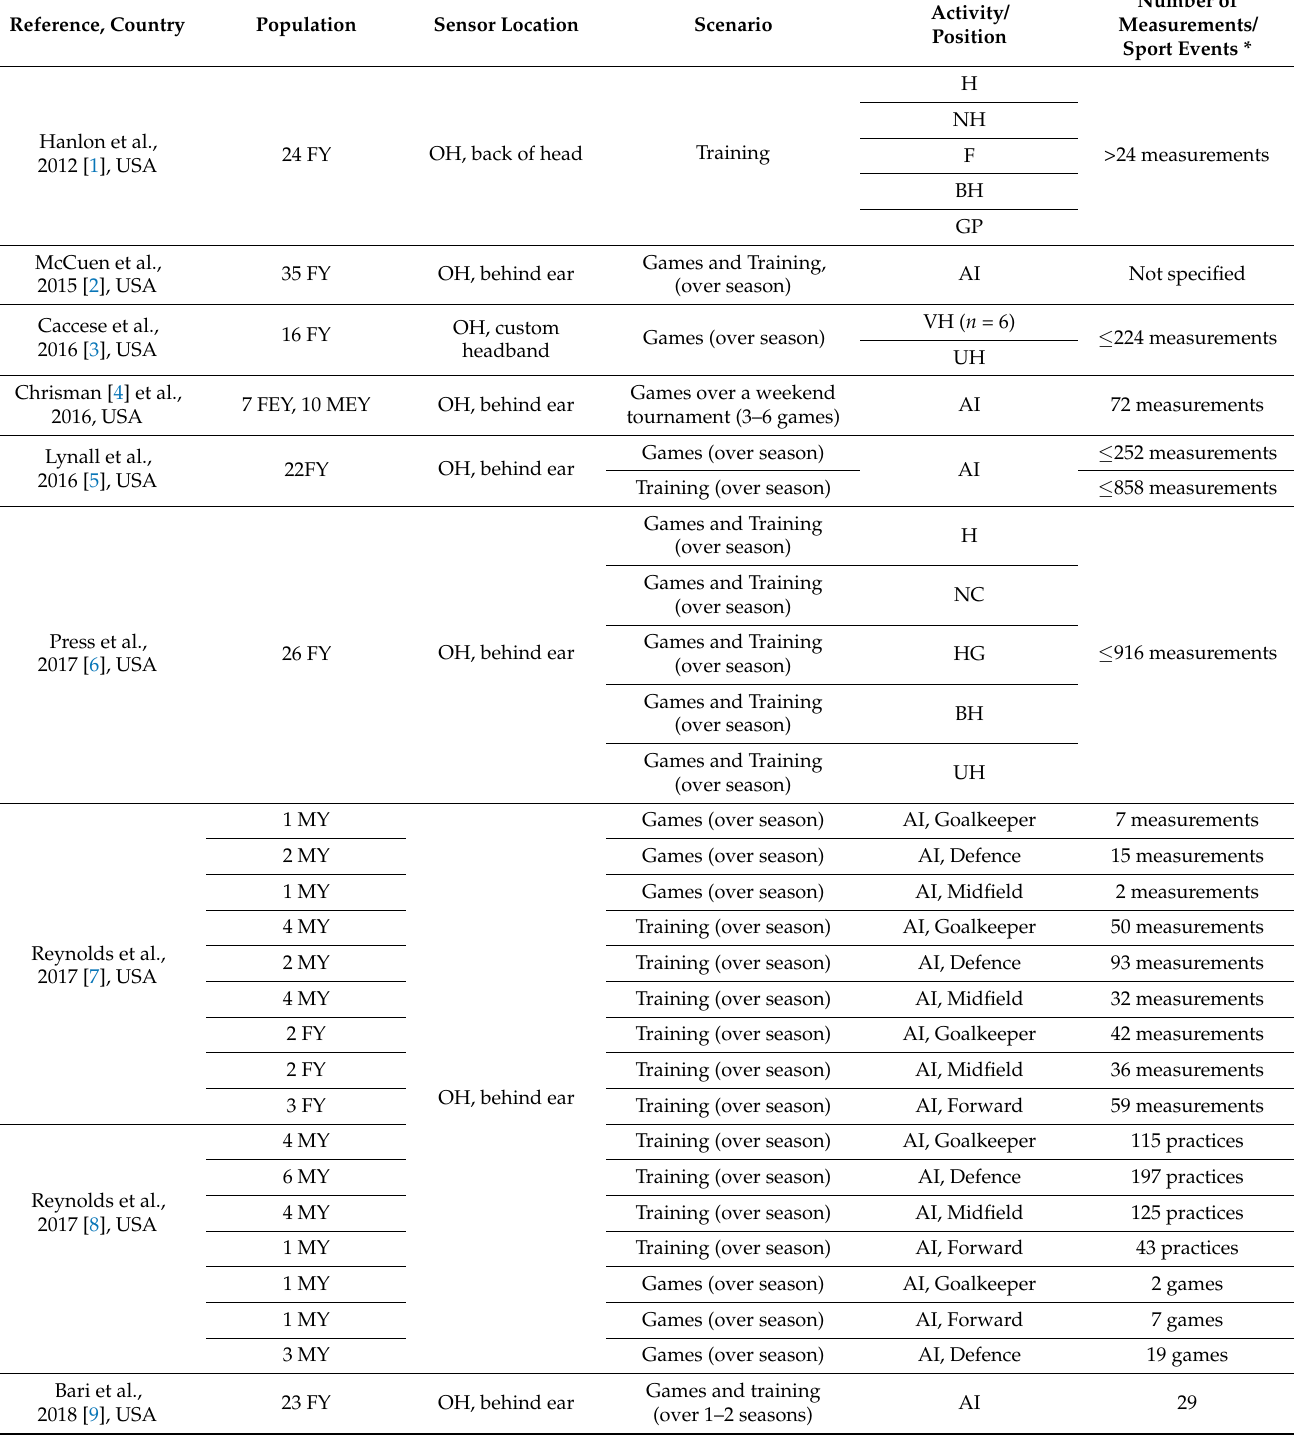
Table 1. Observational studies reporting peak linear and/or rotational accelerations due to heading and other head